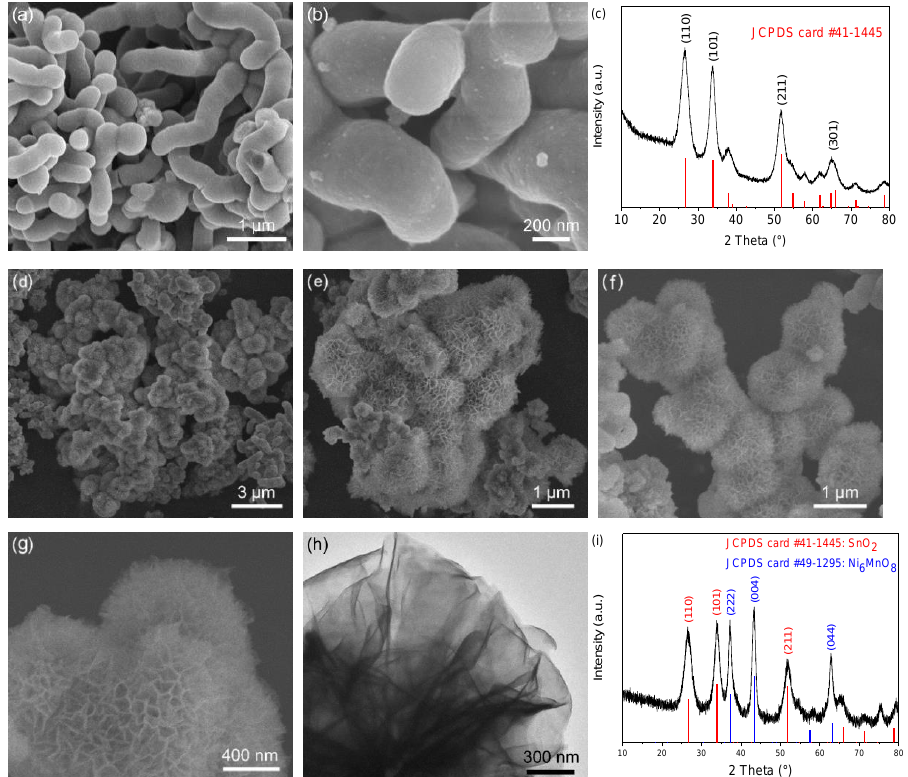
Figure 2. ( a , b ) SEM images and ( c ) XRD pattern of SnO 2 /C precursor. SEM images of SnO 2 @Ni 6 MnO 8 precursor ( d , e ) before and ( f , g ) after annealing. ( h ) TEM image of the Ni 6 MnO 8 nanoflakes on the surface of SnO 2 . ( i ) XRD pattern of the SnO 2 @Ni 6 MnO 8 composite.